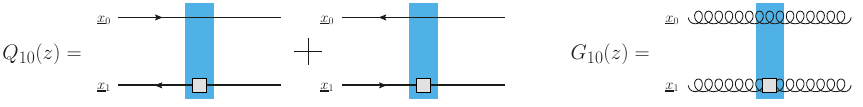
Figure 1 . Diagrammatic representation of the quark ( Q ) and gluon ( G ) polarized dipole ampli- tudes. The shaded rectangle is the shock wave, while the square represents insertions of sub-eikonal